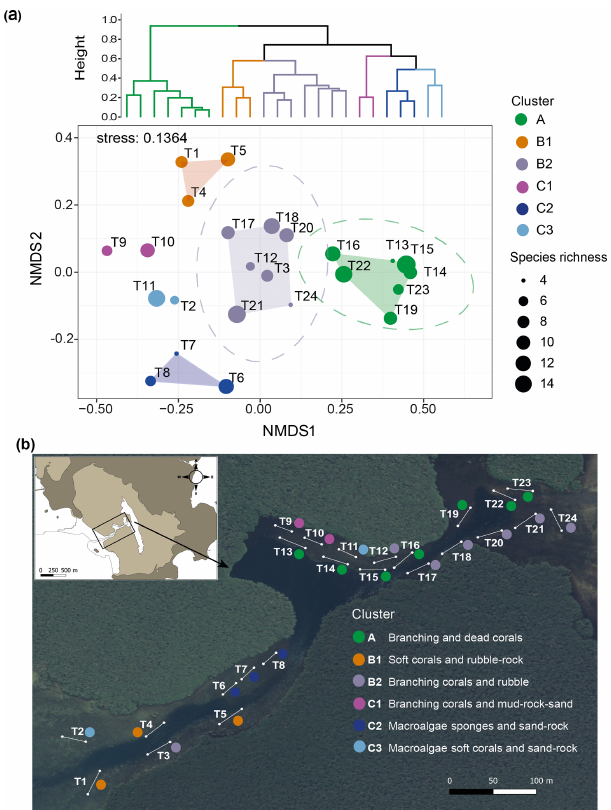
Figure 10. Benthic community and bottom substrate characterization in the Bouraké lagoon. Hierarchical Ward’s method cluster dendrogram (a) and non-metric multidimensional scaling (nMDS) of abiotic and biotic percent cover and species richness per transect (T1–T24) (a) . Colored circles represent clusters of transects identified in the dendrogram; circle size corresponds to species richness. Ellipses represent 95% confidence intervals. Dominant biotic and abiotic descriptors were used to describe the benthic community and bottom substrate for each cluster in (b) . The satellite image is from Georep New Caledonian database (https://georep.nc/), and the QGis software was used for transect